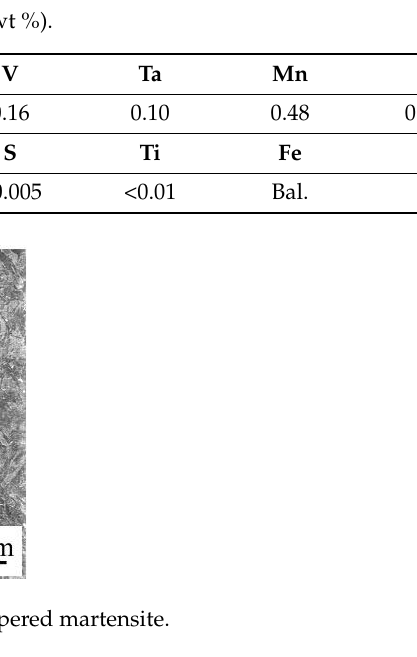
Figure 4. Sketch of EBW with beam oscillation. ( a ) Oscillation with electromagnetic fields. ( b ) Beam oscillating welding. ( c ) Wave function. (Reprinted with permission from ref. [13,14] © (2019) Elsevier, (2019) Elsevier) Table 1. Chemical composition of CLAM steel (wt %).